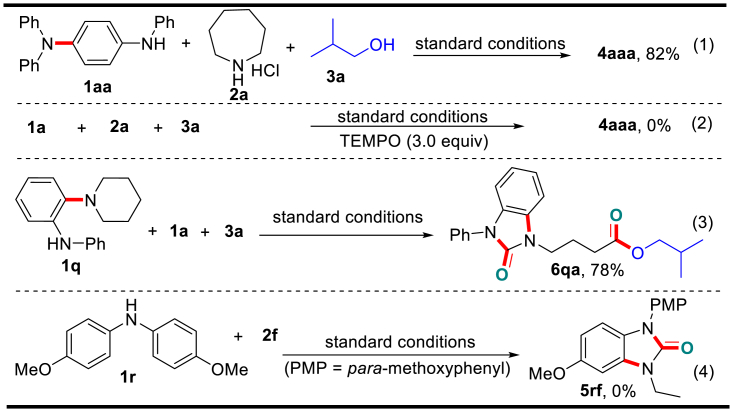
Control ExperimentsAlso see Figures S84–S87.